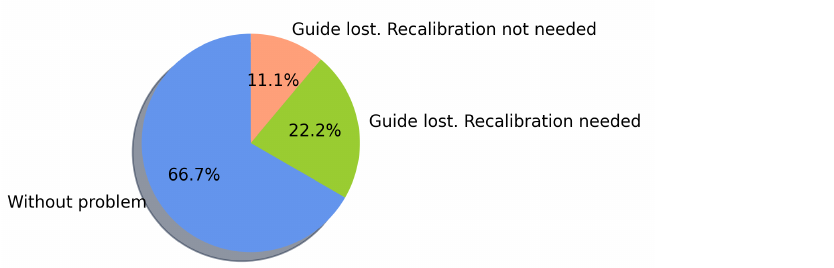
Figure 9. AR line display errors during navigation.